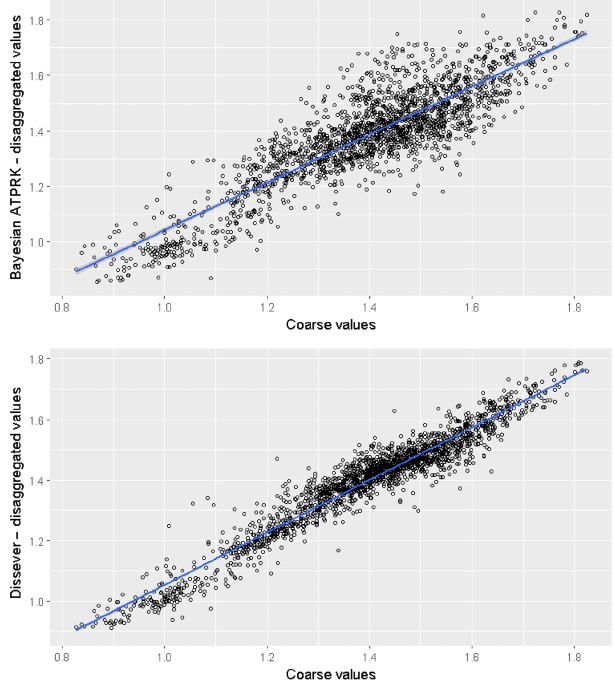
Figure 7. Correlation plots between upscaled disaggregated values from Bayesian ATPRK, dissever, and original coarse-scale block values.